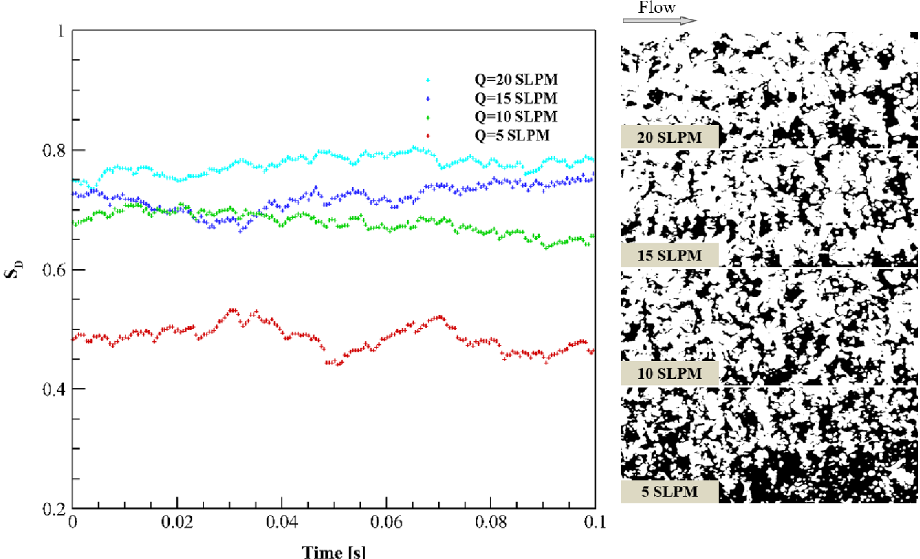
Figure 13. Change of spatial density with time at the free-stream velocity of 7 m/s for various air injection rates. The arrow indicates the direction of the free-stream velocity